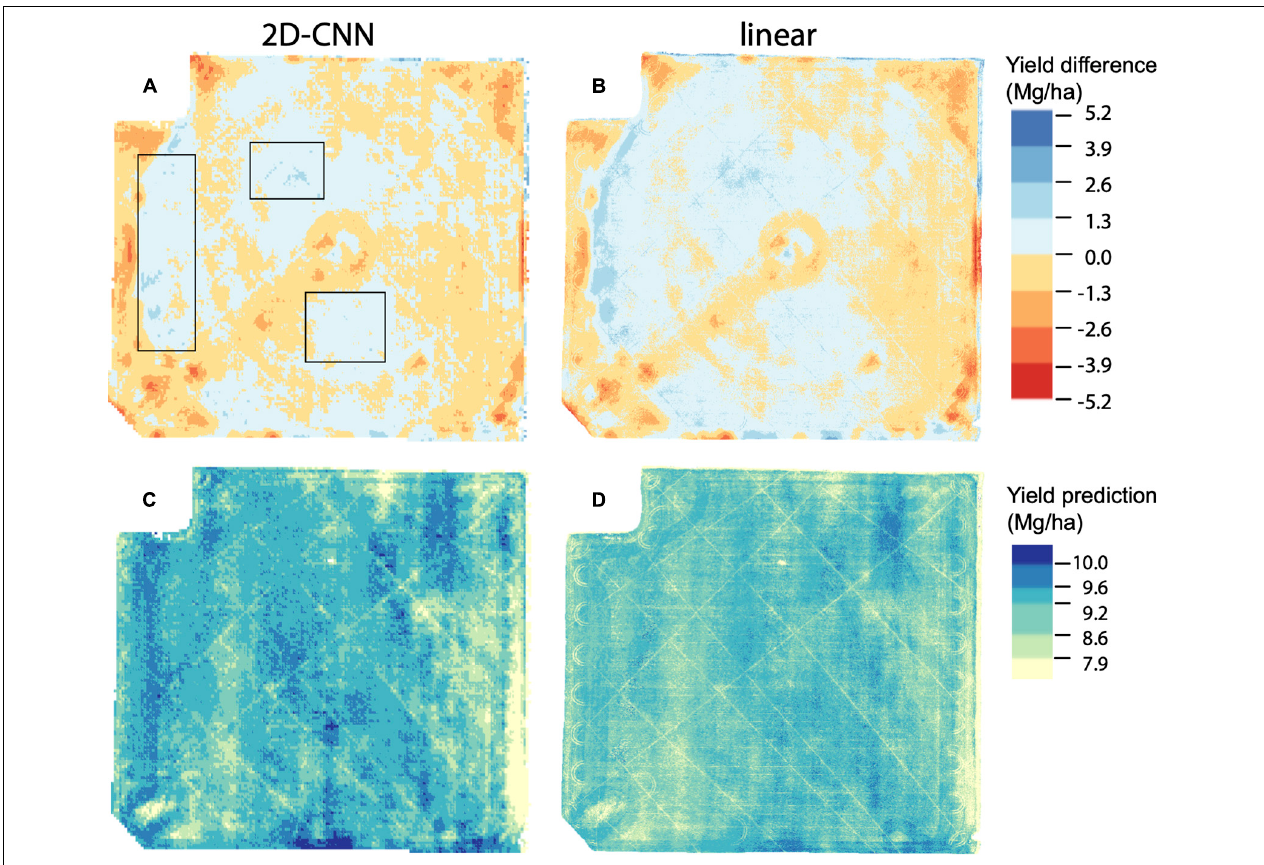
FIGURE 4 | Yield prediction maps based on data for 01 Aug 2019, for models trained on the fold B dataset. Data for 2D-CNN is shown in (A,C) whereas data for linear model is shown in (B,D) . Prediction error (yield difference) is shown in (A,B) and represents observed yield minus predicted yield; (C,D) show predicted yield. Black boxes in (A) indicate regions described in main text where yield was underpredicted to a considerably lesser degree in the 2D-CNN model compared to the linear model. For (A,B) , breakpoints for color scale are evenly spaced. For (C,D) , breakpoints for the color scale are chosen based on the 10th, 25th, 50th, 75th, and 90th percentile values of observed yield. Mg/ha: